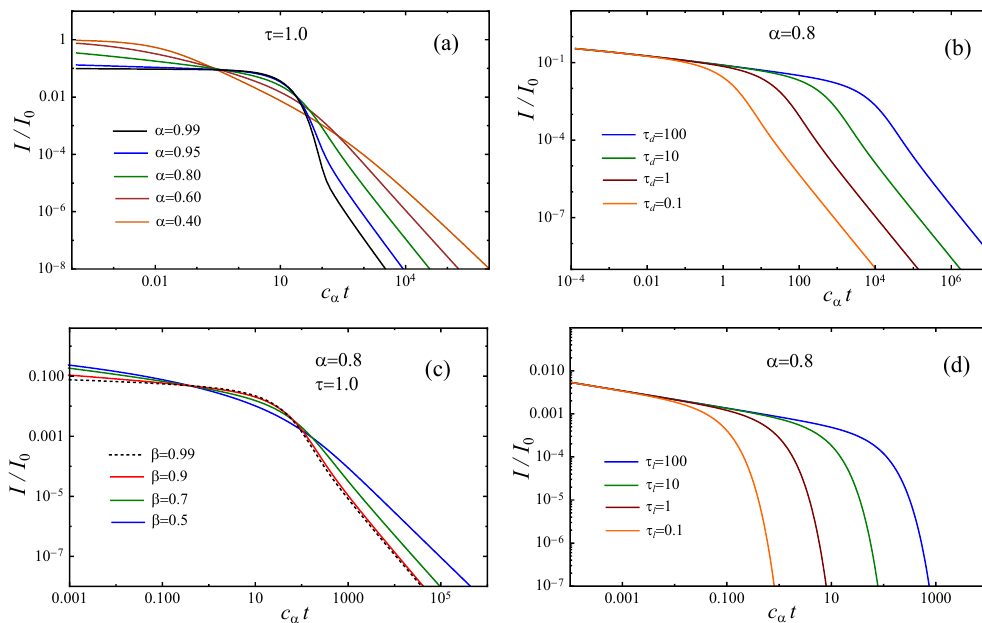
Figure 1. Reduced transient current I ( t ) / I 0 versus t in the log–log scale for different cases: ( a ) inversion of Laplace transform (19) for c α = 1, ω 0 = 10, and τ = 1, and different α values indicated in the plot, ( b ) the same for different τ values at fixed α = 0.8, ( c ) inversion of Laplace transform (23) b 1 = b 2 = 1, ω 0 = 10, α 1 = α = 0.8, and α 2 = β indicated in the plot, and ( d ) transient current (24) for c α = 1, ω 0 = 10, τ = τ l